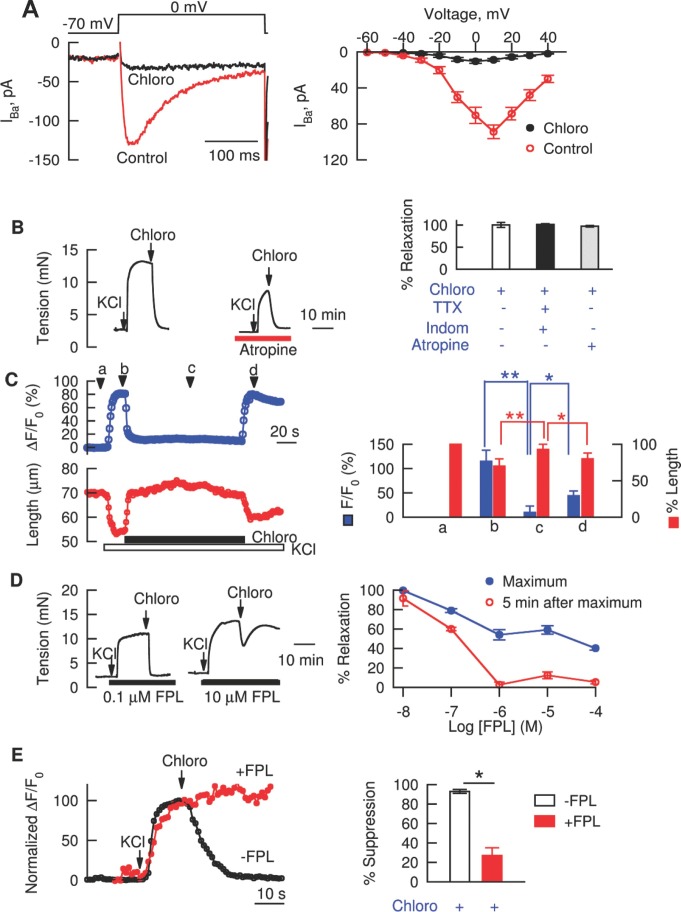
Bitter tastants block L-type VDCCs.(A) Chloro blocked L-type VDCC currents. Left panel displays patch clamp recordings of L-type Ca2+ currents in response to a voltage pulse from −70 mV to 0 mV in the control and in the presence of 1 mM chloro, and the right panel the effect of chloro on the current-voltage (I–V) relationship of the Ca2+ current (n = 5). Ba2+ was used as a charge carrier, and the peak current was used to construct the I–V relationship. Note that the high voltage threshold for activation seen in the I–V relationship, and its sensitivity to FPL and nifedipine [17] indicate these Ca2+ currents resulted from the opening of L-type VDCCs. (B) Bitter tastants relaxed KCl-induced contraction of mouse airways. The left panel shows representative force recordings in response to 60 mM KCl followed by 1 mM chloro in the presence of 100 nM atropine and in its absence. The right panel shows the mean values of the relaxation of KCl-induced contraction by 1 mM chloro in the control (n = 9), in the presence of 100 nM atropine (n = 16), or in the presence of 1 µM tetrodotoxin (TTX) and 1 µM indomethacin (Indom) (n = 6). Note that the inhibition of chloro in the presence of 100 nM atropine was calculated relative to the atropine-resistant contraction in response to KCl. Not shown: 1 mM denatonium relaxed airways precontracted by 60 mM KCl by 97%±4% (n = 5 independent experiments). (C) Relationship between [Ca2+]i and cell length in response to 60 mM KCl and 1 mM chloro. Left panel shows the time course of concomitant changes in [Ca2+]i and cell length and the right the mean ± SEM (n = 15 cells) at the four time points marked on the left. *p<0.05; **p<0.01. (D) FPL 64176 (FPL) dose-dependently inhibited chloro-induced bronchodilation of KCl precontracted airways. Left panel shows two representative recordings, and the right panel the means ± SEM (n = 5–7 independent experiments). 60 mM KCl and 1 mM chloro were used. Given the non-monotonic nature of the relaxation (left), both the greatest reduction in force after chloro (i.e., maximum) and the force reduction 5 min after chloro were measured and divided by the peak force- resting force before application of chloro. (E) FPL inhibited chloro-induced suppression of the rise in [Ca2+]i produced by KCl. Left panel shows original recordings of Ca2+ responses and the right panel the mean ± SEM (n = 28 without FPL, n = 16 with FPL). The values represent as (ΔF/F0 at the peak after KCl−ΔF/F0 at 30 s after chloro)/(ΔF/F0 at the peak after KCl−ΔF/F0 at basal)×100.